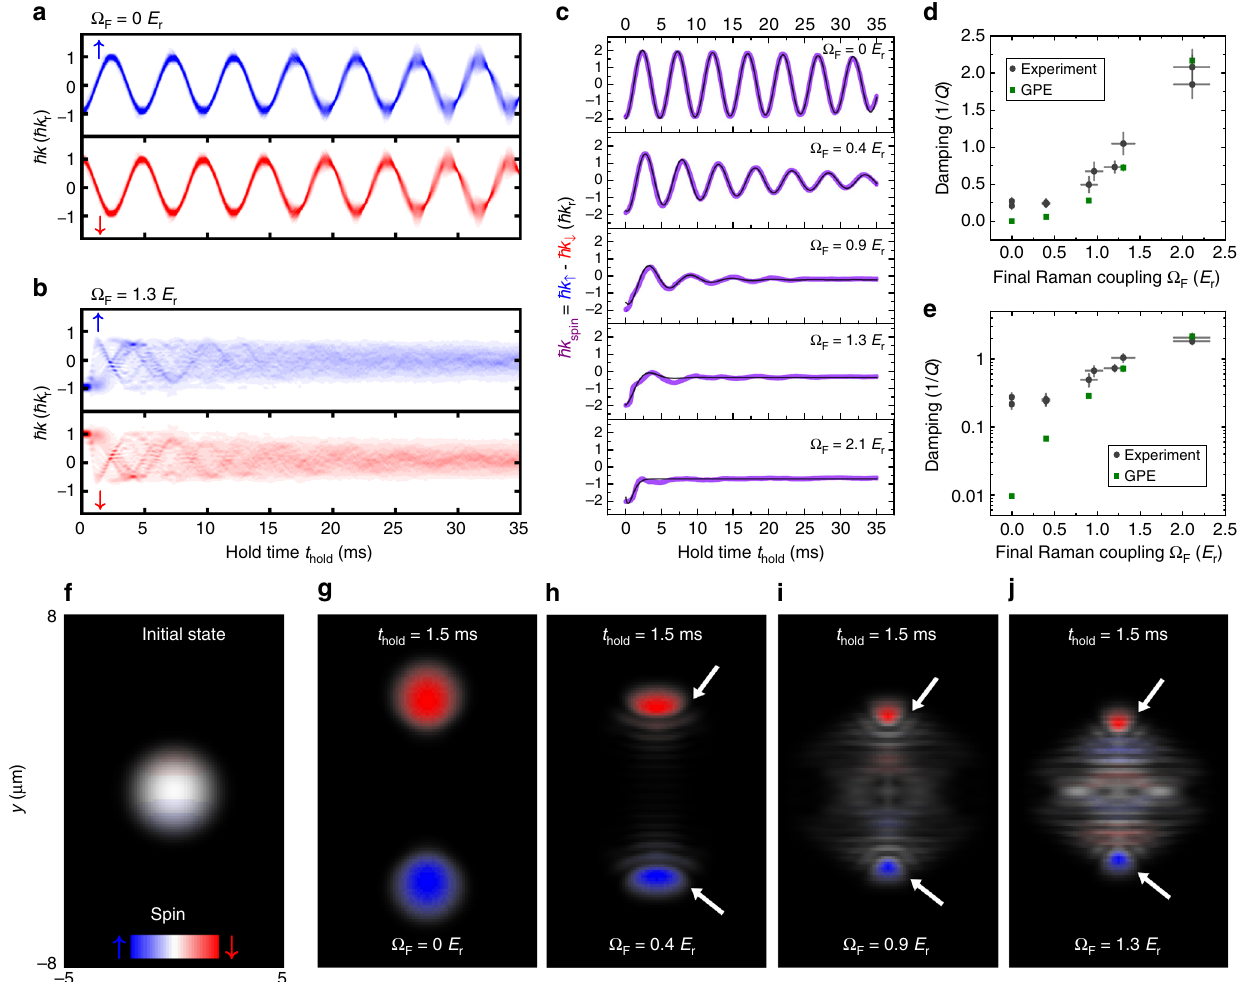
Fig. 6 GPE simulated SDM at various Ω F and the extracted SDM damping compared with experiment. a , b GPE simulations of the 1D momentum-space density distributions of the two bare spin components as a function of t hold for the SDM at Ω F = 0 and Ω F = 1.3 E r , respectively. The 1D momentum density ρ σ ( k y ) is obtained by integrating the 3D momentum density along k x and k z , i.e., momentum densities for sequential hold times ( t hold ) are combined to show the atomic density in momentum space along the SOC direction versus t hold . c GPE simulations of the SDM damping versus t hold at various Ω F . The violet lines are the ħ k spin (de fi ned as the difference between the CoM momenta of the two spin components) as a function of t hold for various Ω F . The CoM momentum ( ħ k ↑ , ↓ ) of each bare spin component (at a given t hold ) is calculated by taking a density-weighted average of the corresponding 1D momentum density distributions such as those shown in a , b . The black lines are damped sinusoidal fi ts for the calculated ħ k spin to extract the corresponding SDM damping (1/ Q ) which is shown in d along with the experimental data reproduced from Fig. 3f. e Replotting of d with 1/ Q shown in logarithmic scale. f – j In situ (real space) atomic densities calculated from GPE simulations. f Initial in situ 2D density at Ω = Ω I (right before applying spin-dependent electric fi elds E σ ). g – j In situ 2D density at t hold = 1.5 ms (after the application of E σ ) for Ω F = 0, 0.4 E r , 0.9 E r , and 1.3 E r , respectively. For f – j , the density is designated by brightness and the bare spin polarization by colors (red: ↓ , blue: ↑ , white: equal spin populations). The 2D densities ρ σ ( x , y ) in f – j are obtained by integrating the 3D atomic density along z , i.e., ρ σ ð x ; y Þ ¼ simulations used the following parameters representative of our experiment: Ω I = 5.2 E r , δ R = 0, N c = 1.6 × 10 4 , ω z = 2 π × 37 Hz, ω x = ω y = 2 π × 205